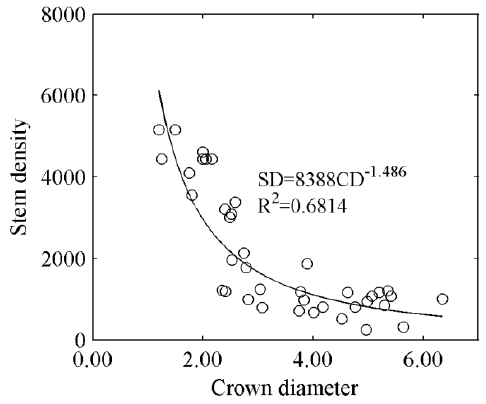
Figure 7. Empirical relationship between crown diameter and stem density used in INFORM to link stem density (SD) to crown size (CD) ( n =